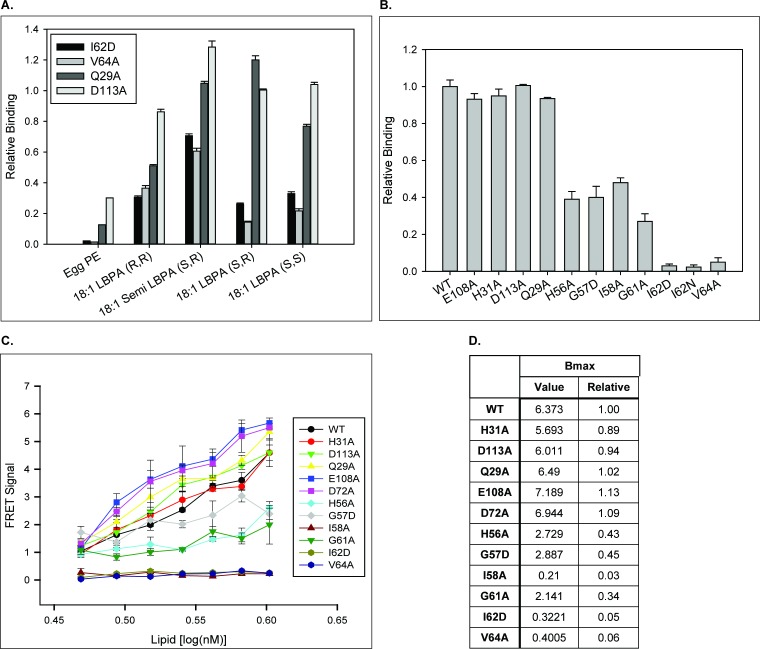
NPC2 binds to LBPA via the hydrophobic-knob domain.Binding of NPC2 WT and mutant proteins to (A) LBPA isomers and (B), 18:1 (S,R) LBPA was detected using LBPA Snoopers and membranes spotted with 500 pmol phospholipid, respectively, as described under Methods. Relative binding is represented as (A) the integrated density of the blots, relative to WT NPC2, ± SE (n = 3) and (B) the signal intensity detected with the LI-COR system ± SE (n = 3) (C). HTRF analysis: WT or mutant NPC2 protein was incubated with biotin-C12-ether LBPA, streptavidin-d2 conjugate and europium cryptate–labeled anti-His antibody in detection buffer, as described in Methods. FRET signal between europium cryptate and streptavidin was detected with a HTRF capable Envision late reader as described in Methods. (D) FRET signal was analyzed with the One site–specific binding function (Graphpad) and the Bmax extrapolations were used to infer binding capacity between recombinant NPC2 protein and biotin-C12-ether LBPA. Results are representative of three experiments, with deviations < 20%.